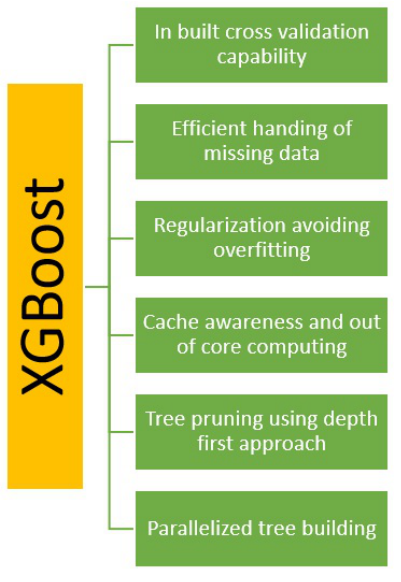
Figure 5. XGBoost